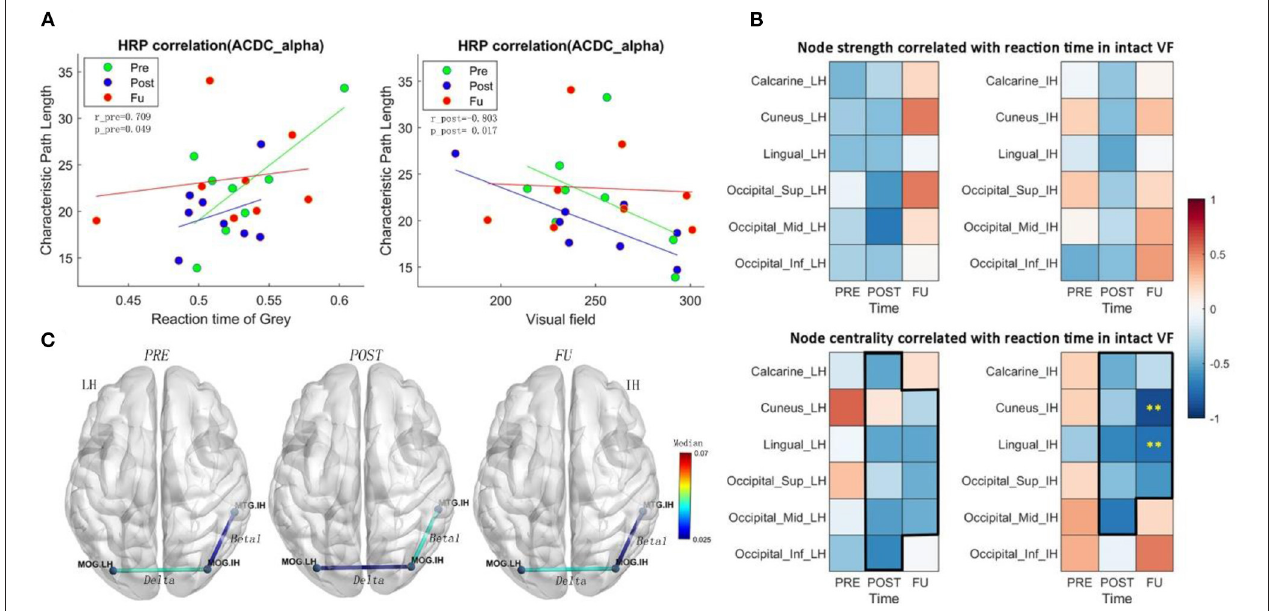
FIGURE 3 | (A) CPL in the alpha band of ACDC patients correlates positively with RT of residual visual area before treatment and correlates negatively with the intact visual field after treatment. It indicates that the larger the intact visual field in the ACDC group after treatment, the lower is the CPL in the ACDC group in the alpha band. A lower CPL is a sign of decreased average shortest path length in the resting state of brain functionality. When neural processing in the brain has a lower CPL; this can be interpreted as a biomarker that brain process is globally enhanced and more efficient. (B) Heat map showing correlation coefficients (ranging from − 1 to + 1) between brain node measures and reaction time in the intact VF of the ACDC group. The upper panel shows a trend of a treatment effect in the intact hemisphere (IH) and the lesioned hemisphere (LH) in both hemispheres; the lower panel shows a clear pattern after treatment: at follow-up, faster reaction time was associated with higher brain node centrality. Significant negative correlation was observed in cuneus and lingual in the IH. This could indicate that the visual function recovery after brain stimulation could be due to the multifactor integration of the lesioned and the intact hemisphere. (C) ACDC significantly reduced the long coherence between the lesion and intact occipital cortex in the delta band after POST ( p < 0.05). Also, low beta was enhanced after POST between the intact occipital and intact temporal ( p < 0.05). Each connectivity was measured between LH and IH occipital lobe; LH, lesion hemisphere; IH, intact hemisphere; MTG, Temporal_Mid; MOG, Occipital_Mid;